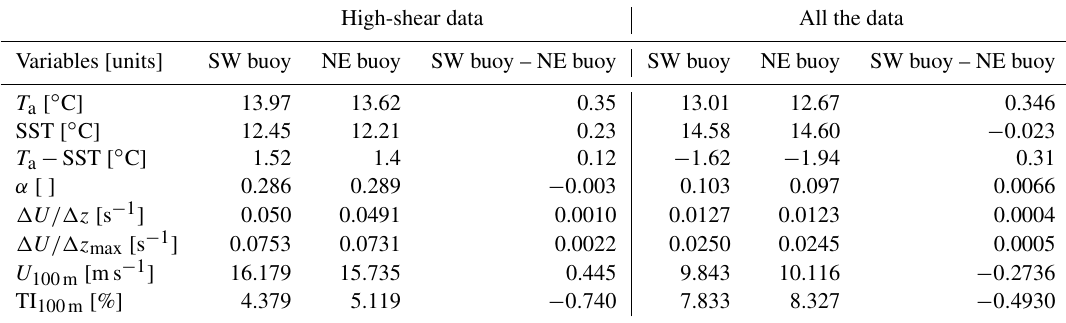
Table 2. Comparison of the mean atmospheric variables between the NE and SW buoys. High-shear data All the data Variables [units] SW buoy NE buoy SW buoy – NE buoy SW buoy NE buoy SW buoy – NE